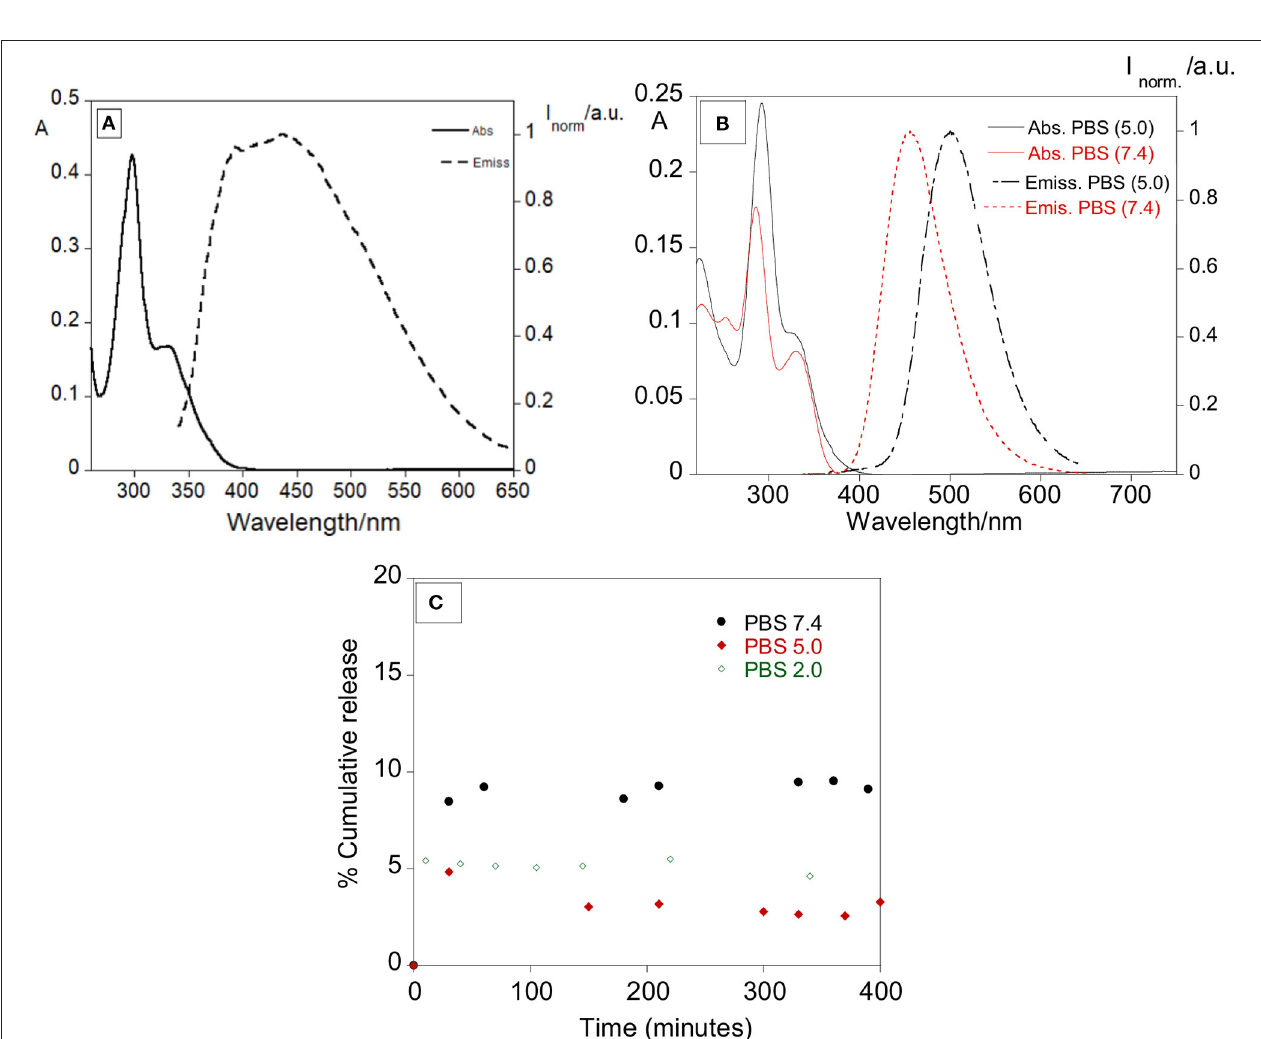
FIGURE 5 | (A) Absorption and emission spectra of ofloxacin in DMSO ( λ exc = 330nm). (B) Absorption and emission spectra of ofloxacin in PBS at pH 5.0 and pH 7.4. ( λ exc = 330nm). [Ofloxacin] = 1 × 10 − 5 M, r.t. (C) Percentage of cumulative release with time of ofloxacin in PBS pH 7.4, PBS pH 5.0, and PBS pH 2.0.